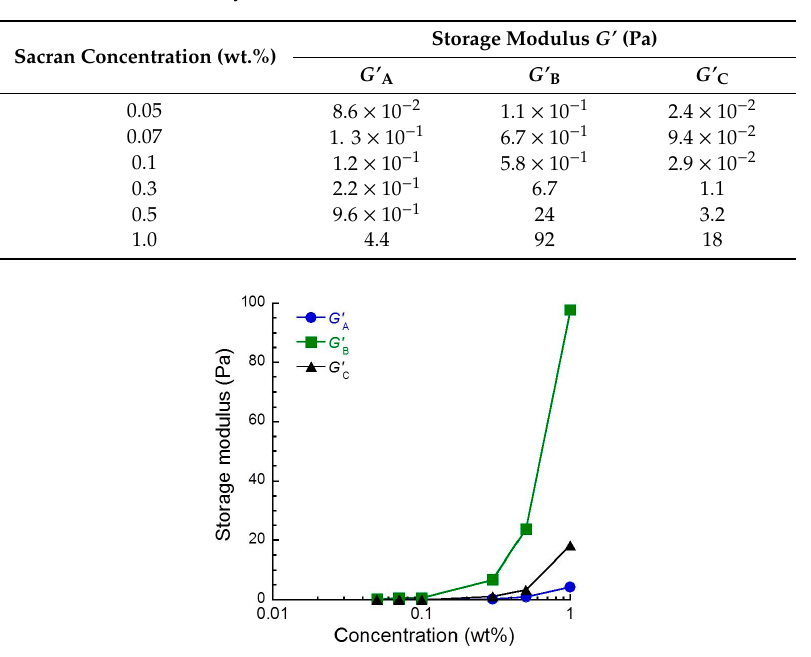
Table 1. Storage modulus for sacran aqueous solution with various concentrations: G’ A : before shear; G’ B : after shear; G’ C : after recovery.